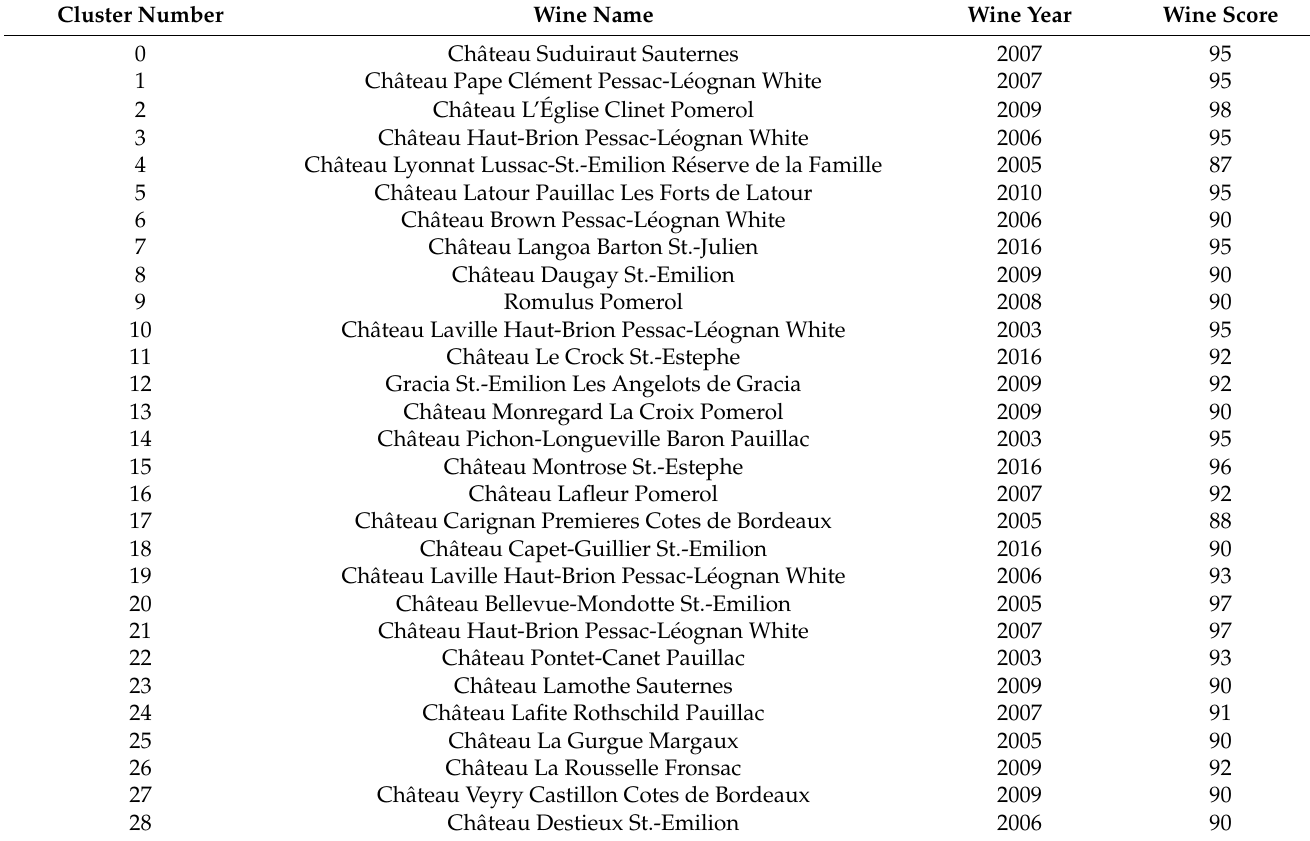
Table 2. Best wine representations in each cluster at optimum cluster number (K = 43). The wines shown above, with their respective production years and scores, are the wines most similar to the centroid values of each cluster number. Each wine listed contains the closest similarities to all other wines within their respective group